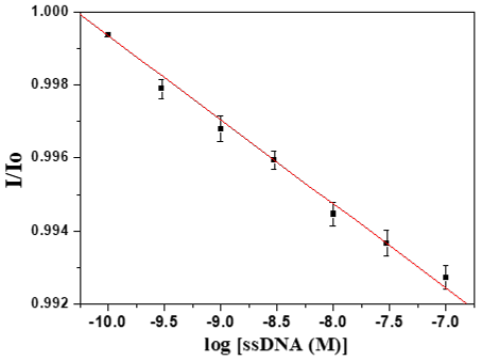
Figure 6. Calibration graph of a FOPPR biosensor using a 30-mer H5-5’ ssDNA probe immobilized at 5’-end in response to 30-mer target H5 ssDNA (n = 5).